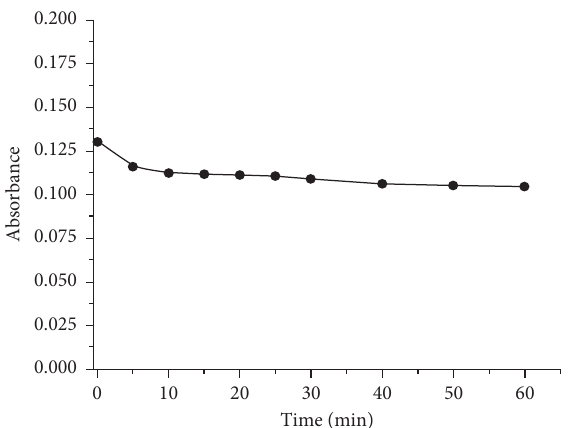
Figure 4: Effect of heating time on the absorbance of the Pd(II)- p -ITYBA complex at a wavelength of 450nm (C